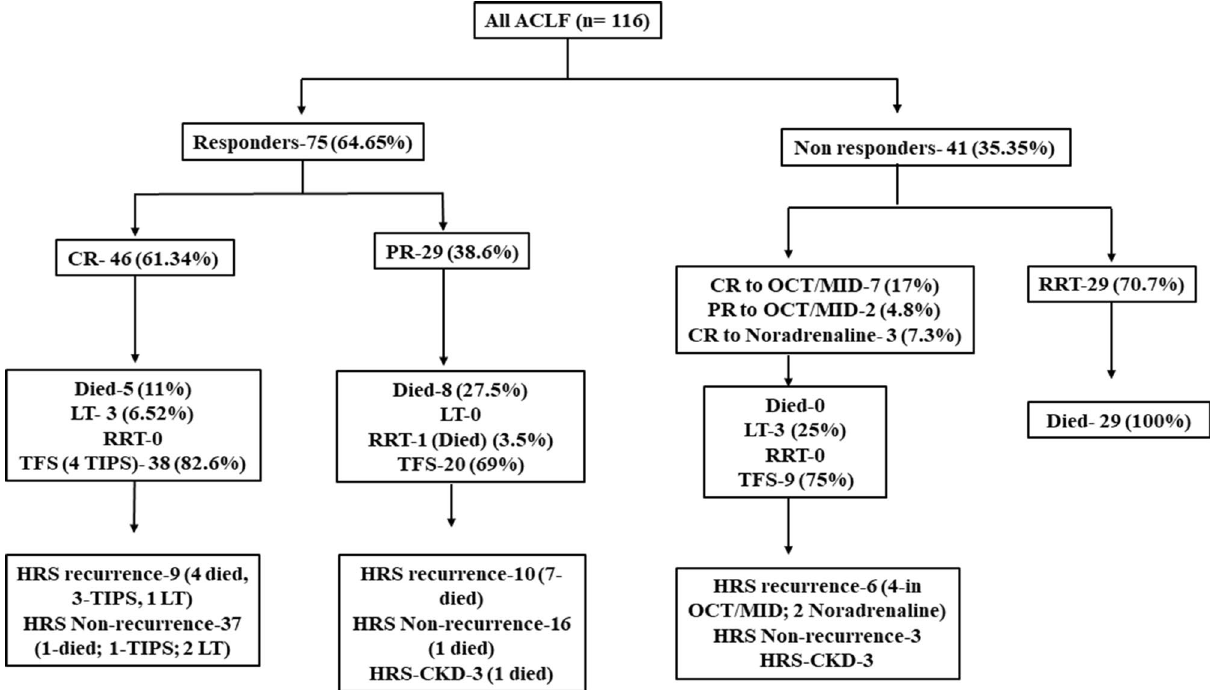
Figure 1. The course of HRS-AKI in the whole cohort. Of the 116 patients, 75 were responders, and 41 were non-responders. In the responder group, 46 patients achieved a complete response, and 29 patients achieved a partial response. Of the 41 non-responders, 29 required renal replacement therapy, and those requiring RRT succumbed. Nine patients of the non-responders were treated with octreotide and midodrine, and the